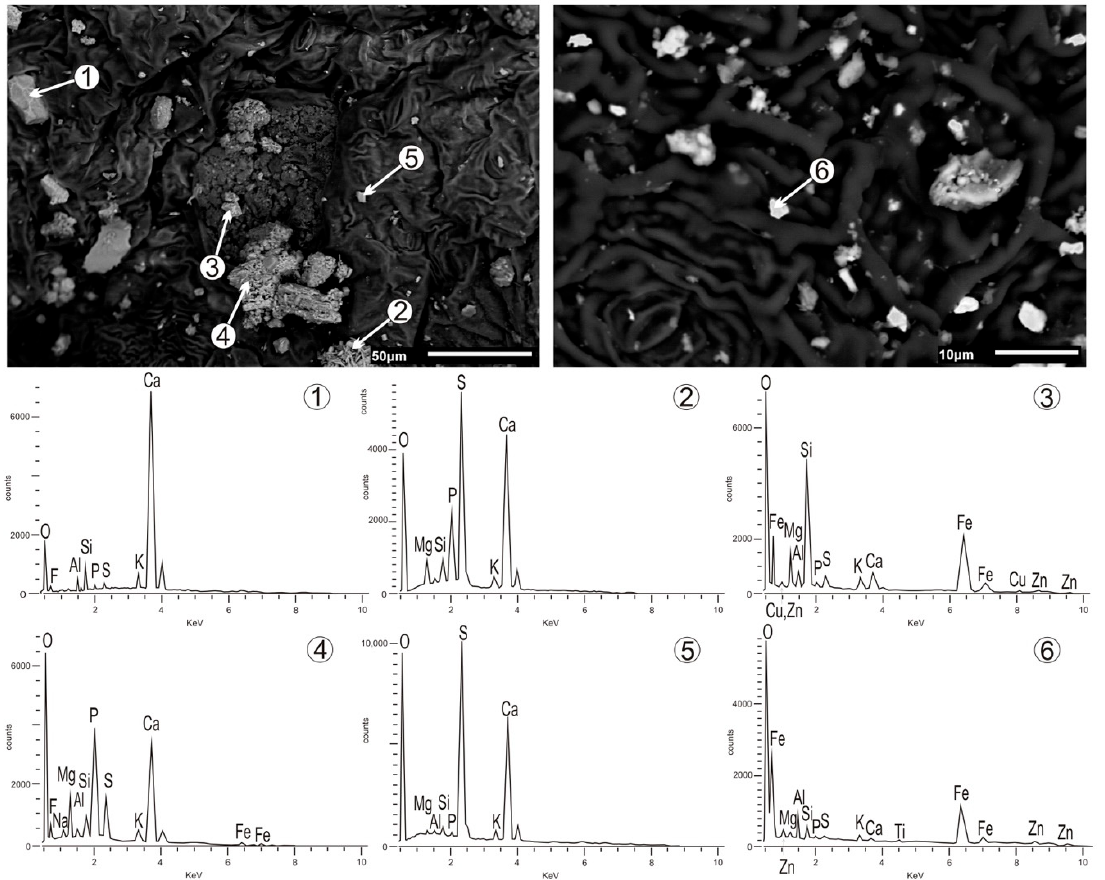
Figure 2. BSE image of P . nigra leaves taken from site 3 and representative energy-dispersive X-ray spectroscopy (EDX) spectra. Spectrum 1 —calcite; spectrum 2 —calcium sulphates with P (phospho-gypsum); spectrum 3 —iron oxide; spectrum 4 —relict of primary phosphorite phase (probably apatite); spectrum 5 —calcium sulphate (gypsum/anhydrite); spectrum 6 —iron oxide with Zn.